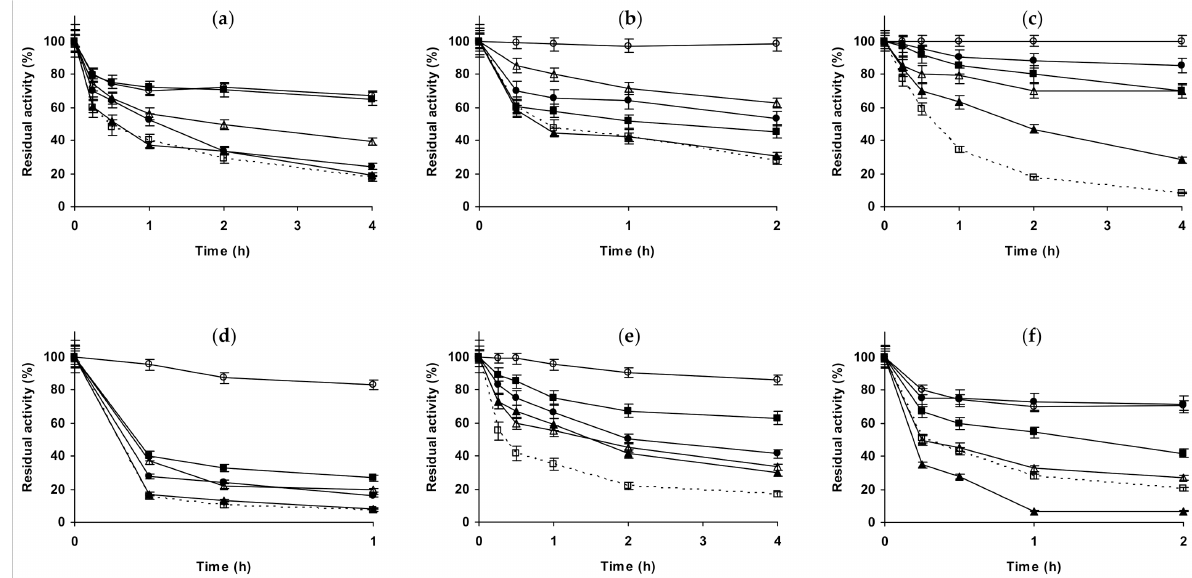
Figure 2. Effect of ionic strength and inactivation pH on the stability of different immobilized preparations of CALB. Octyl-CALB: ( a ) pH 5.0 and 83 ◦ C; ( b ) pH 7.0 and 80 ◦ C; ( c ) pH 9.0 and 58 ◦ C. Glutaraldehyde-CALB: ( d ) pH 5.0 and 78 ◦ C; ( e ) pH 7.0 and 70 ◦ C; ( f ) pH 9.0 and 60 ◦ C. Other specifications are described in the Methods section. Dotted line, empty squares: references; full triangles: 1 M NaCl; empty triangles: 3 M NaCl; full circles: 1 M (NH 4 ) 2 SO 4 ; empty circles: 3 M (NH 4 ) 2 SO 4 and full squares: 1 M Na 2 SO 4